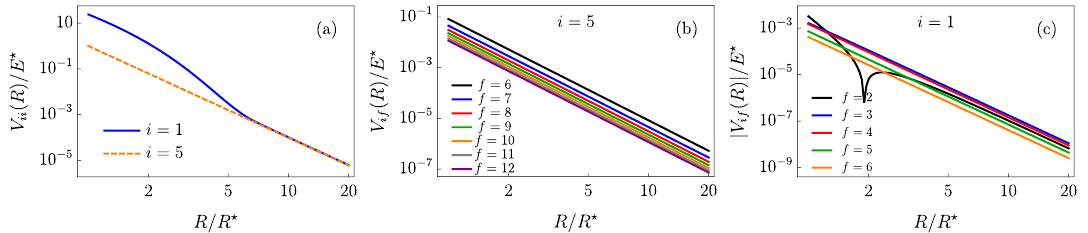
Figure 2. ( a ) Diagonal effective potentials for the most weakly bound state (blue) and the 5th one counting from the dissociation threshold (orange). ( b ) Couplings between the 5th vibrational state and the ones right below it as a function of the atom–molecule distance. ( c ) Same couplings calculated for the most weakly bound state. The binding energies E v ≈ 2 · 10 4 E (cid:63) for v = 5 and 0.16 E (cid:63) for v = 1.